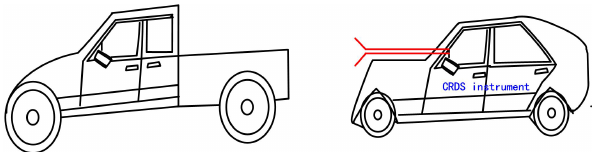
Figure 10. The diagram of the movable van loaded with the CRDS